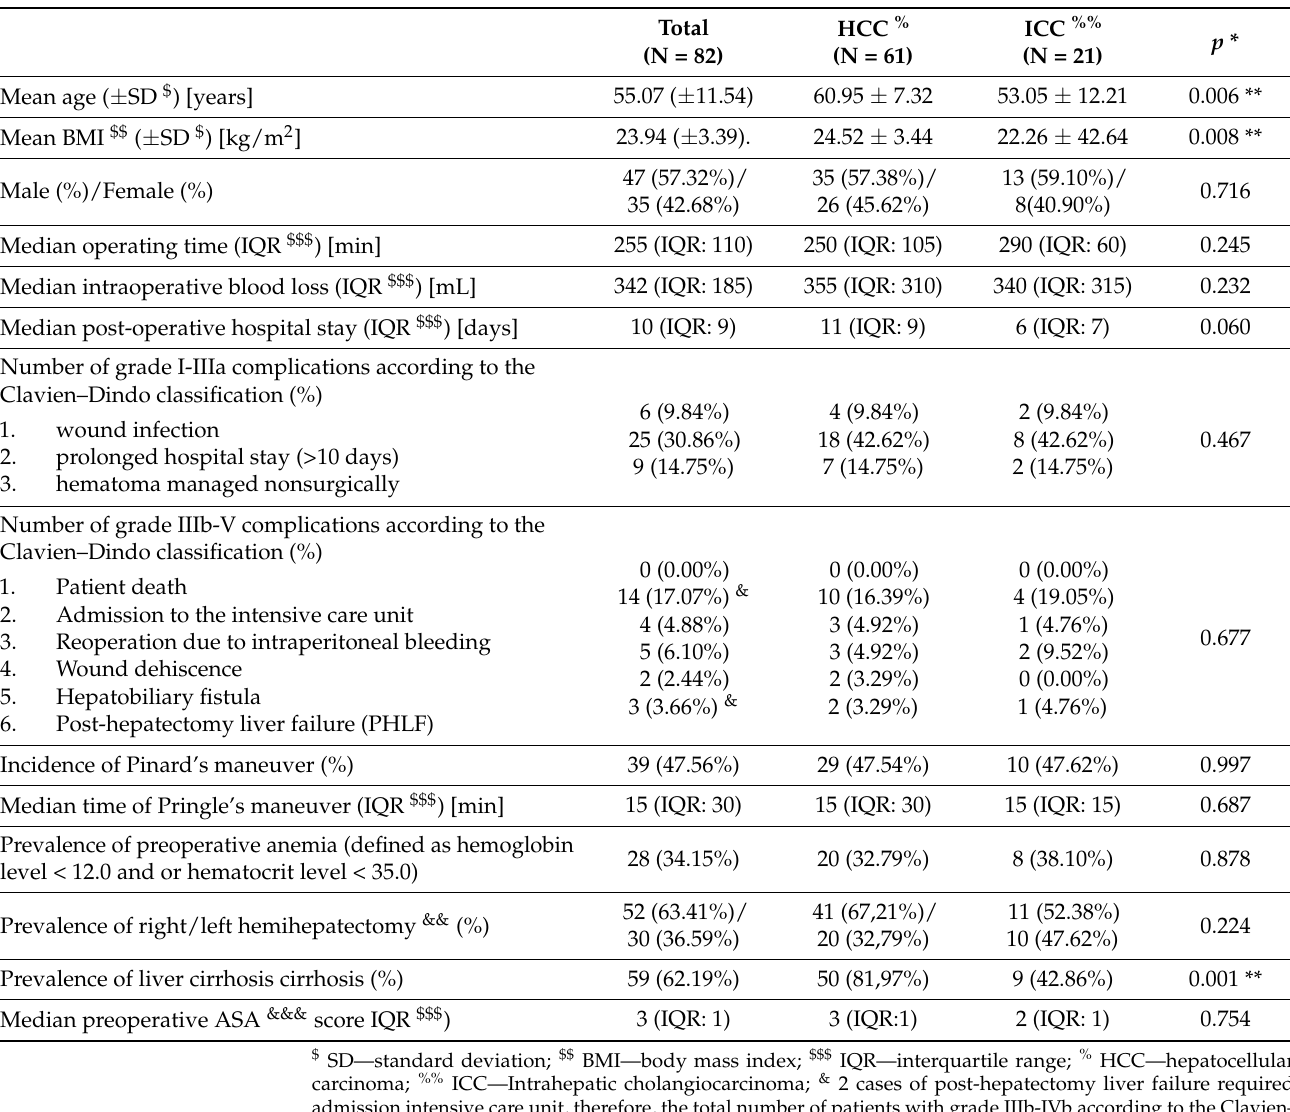
Table 1. Baseline patients characteristics to the type of cancer,